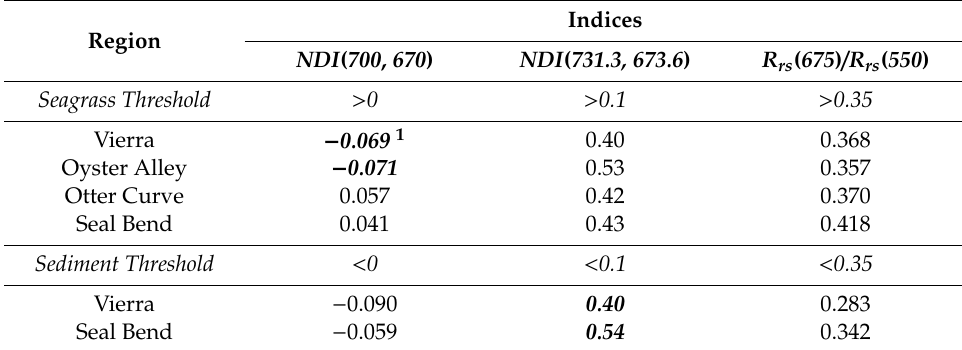
Table 2. Normalized di ff erence indices (NDI) and ratios applied to remote sensing reflectance retrieved from the PRISM imagery over seagrass and sediment pixels. Indices Region NDI ( 700 , 670 ) NDI ( 731.3, 673.6 ) R rs ( 675 ) / R rs ( 550 ) Seagrass Threshold > 0 > 0.1 > 0.35 Vierra − 0.069 1 0.40